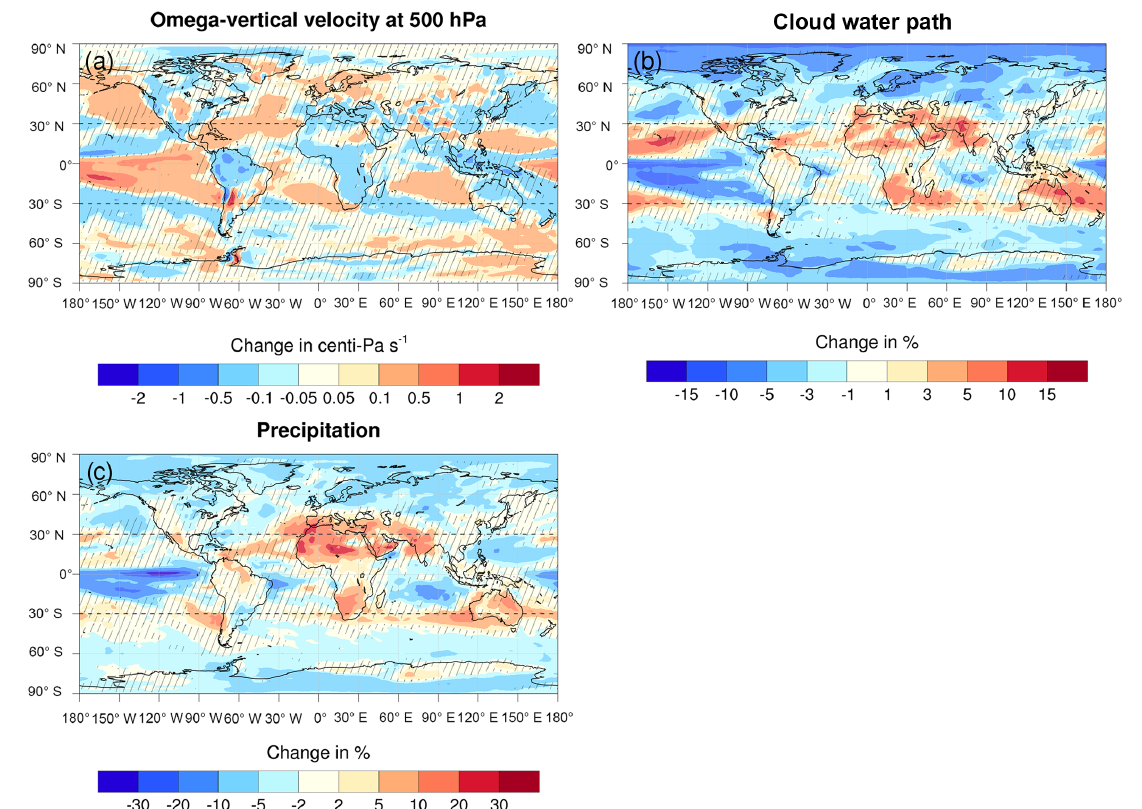
Figure 9. The multi-model mean difference between the G4sea-salt experiment and RCP4.5 averaged over years 2035–2065. The multi- model mean difference refers to the mean of all three models, NorESM1-M, GISS-E2, and HadGEM2-ES. Hatching denotes areas where the models disagree on the sign of the change. Change in (a) omega-vertical velocity at 500hPa (positive values corresponds to reduced upward